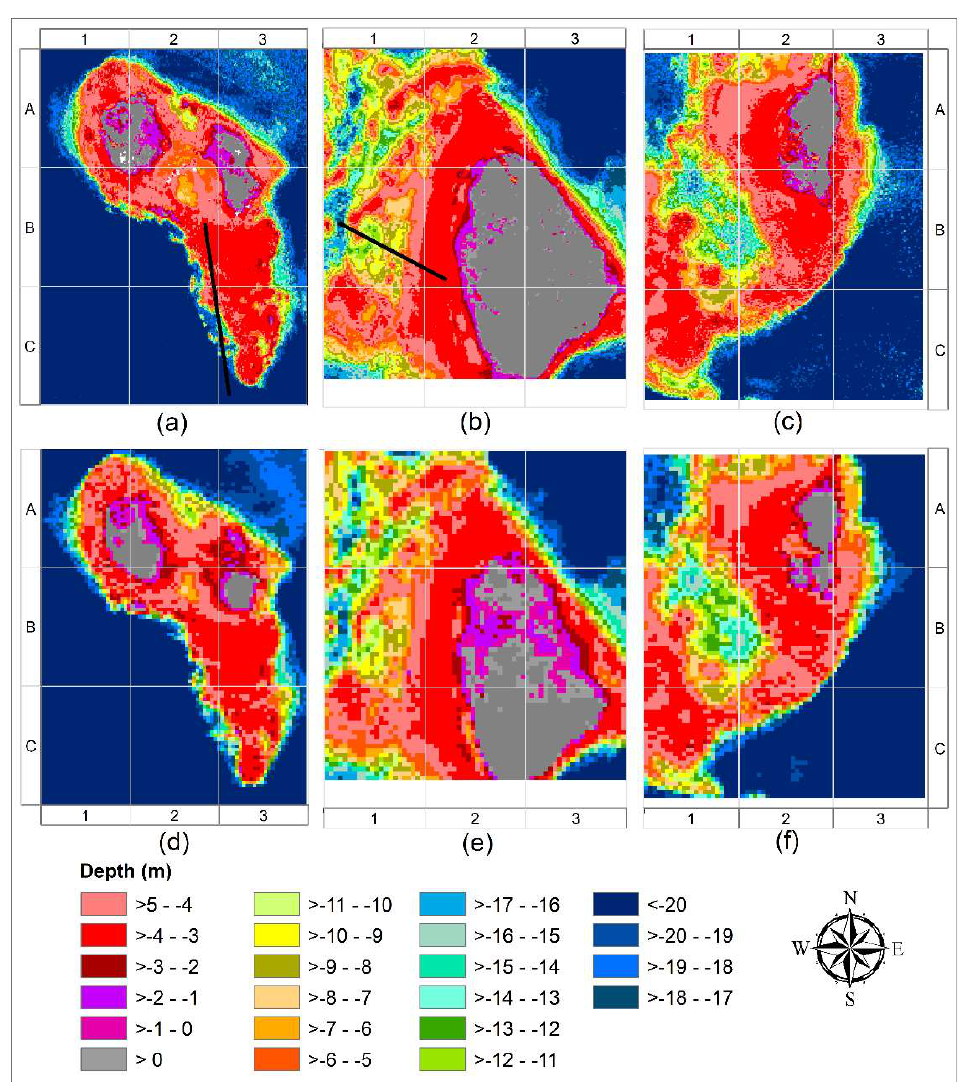
Figure 6. Shallow water depth model based on AGWR approach using 75% training data from Sentinel-2A (a-c) and Landsat 8 OLI/TIRS (d-f) applied on three area of interest (a, d) AoI-1, (b, e) AoI-2, and (c, f) AoI-3. Black lines in (a, b) are the cross profiles location when comparing depth information from